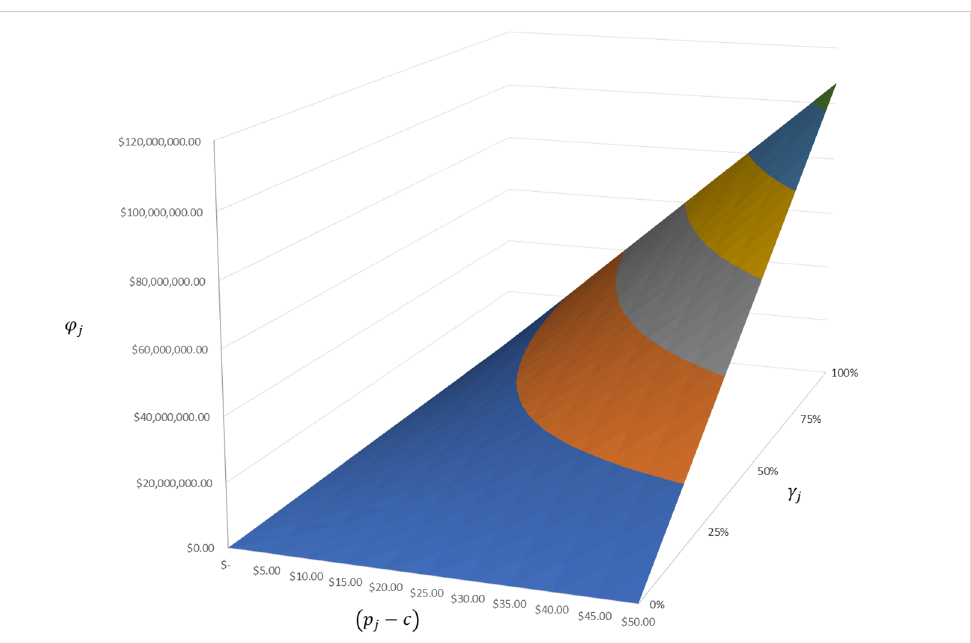
Figure 1. Expected transfer value of Robert Lewandowski depending on the profit margin of merchandising products and the quota of potential buyers (own calculation).